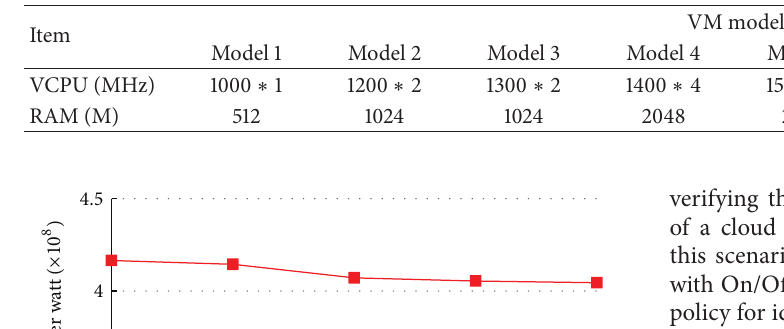
Table 5: VM models for loads of data center.